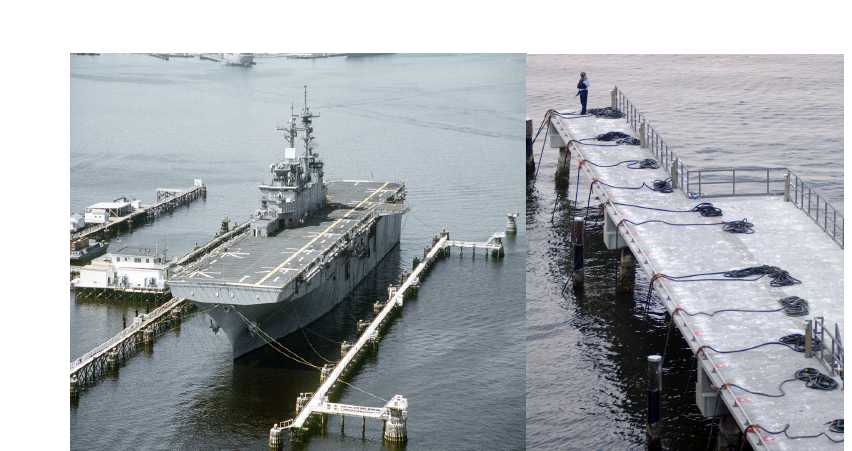
Figure 7 – An aircraft carrier is connected to electrical cables in the port due to the removal of a magnetic field (time saving) (http://www.maritimequest.com/warship_directory/us_navy_pages) Рис . 7 – Авианосец привязан к причалу электрическим проводом для размагничивания ( экономия времени )